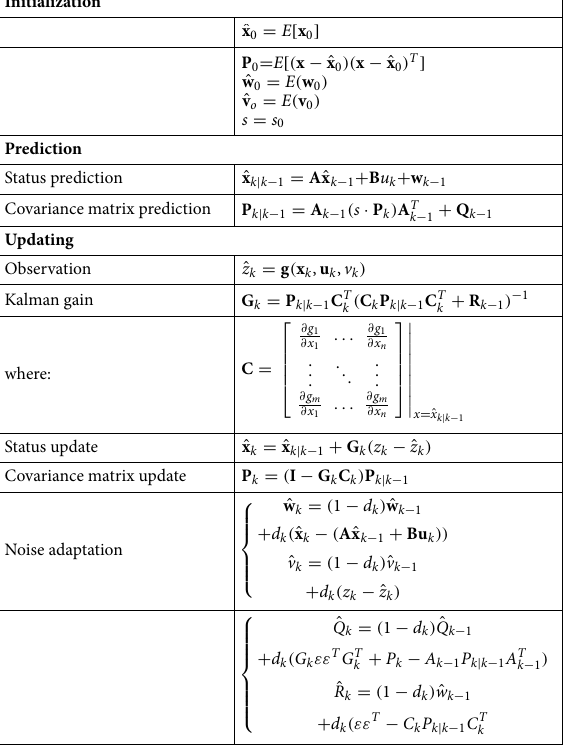
Table 3. Improved EKF